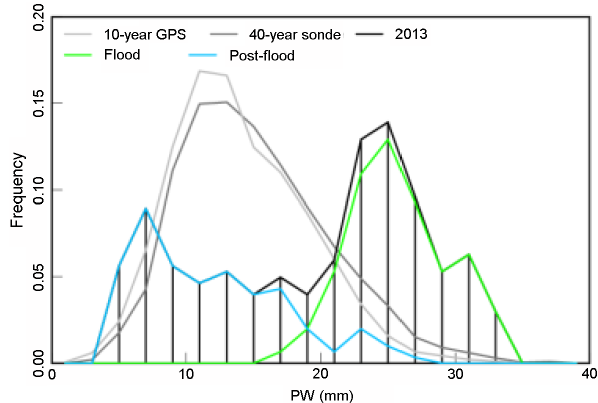
Figure 7. Statistical frequency distributions for the month of September with 2013 GPS PW data over Boulder (black line), 40 years of climatologically averaged radiosonde PW data over Denver (dark grey line), and 10 years of climatologically averaged GPS PW data over Boulder (light grey line). September 2013 GPS PW data was split into two halves: 1–15 September 2013 (flood; green line) and 16–30 September 2013 (post-flood; blue